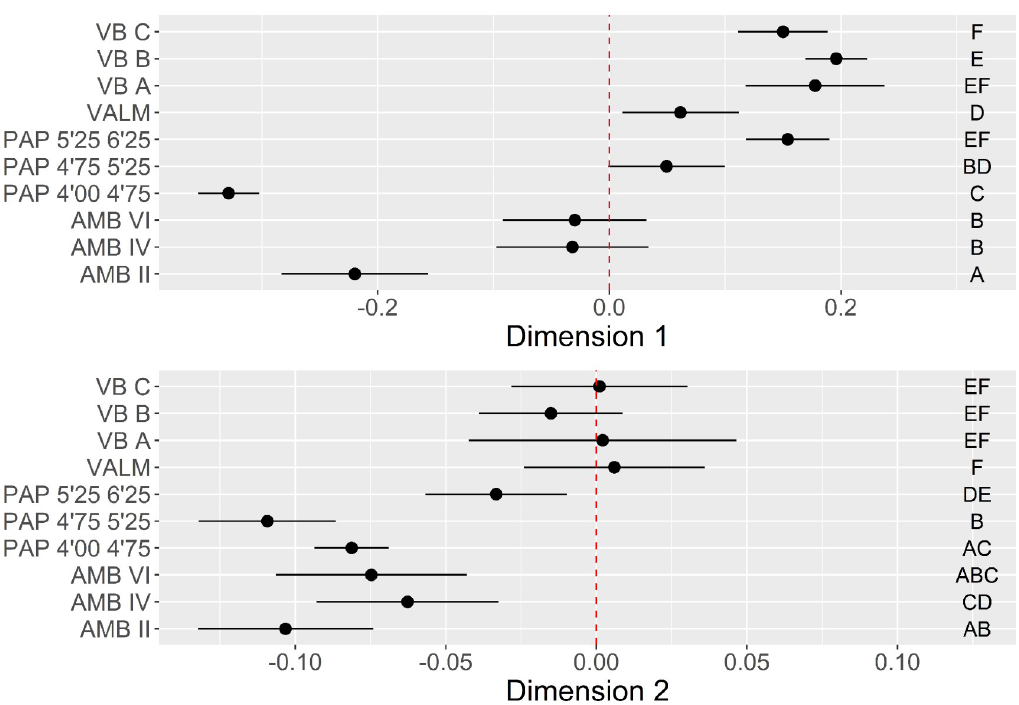
Fig 10. Dorsal surface convexity multi-comparison bootstrap ANOVA. Error bars represent 95% confidence interval from the mean. Contexts sharing the same set of letters do not present statistically significant difference (p-value � 0.05).